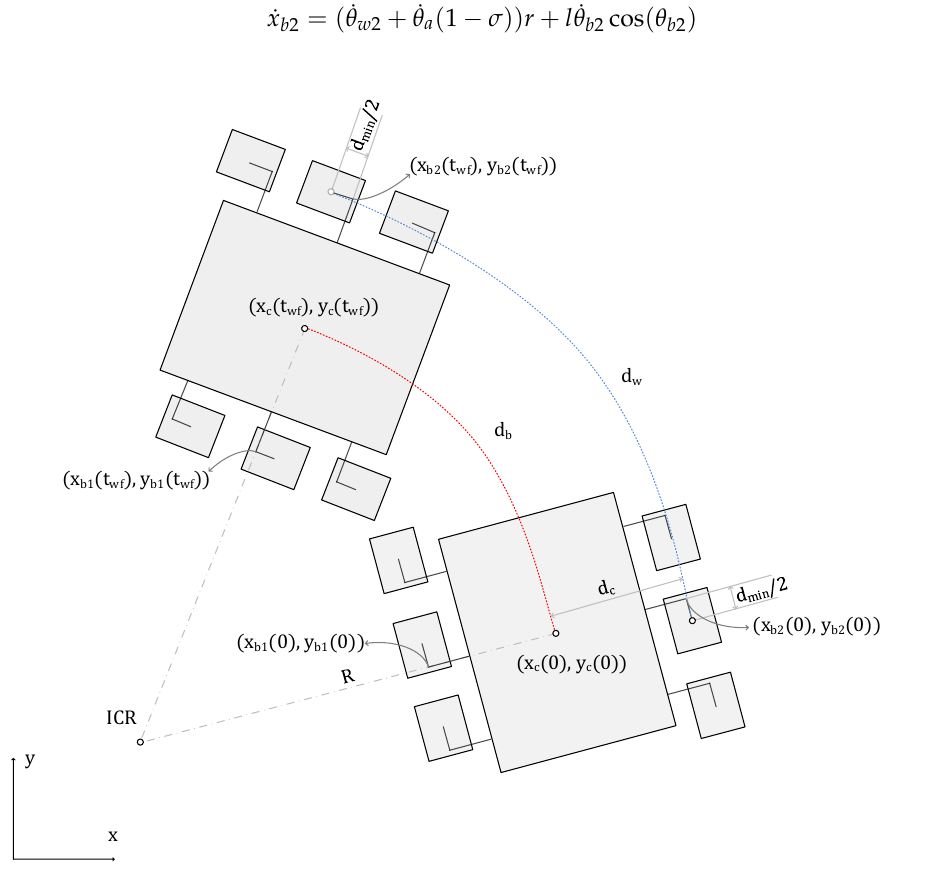
Figure 4. Diagram that shows the trajectory of the rover in the XY plane for the acceleration step. As shown, the rover performs a curve, whose turning radius can be estimated as an ICR with a radius R